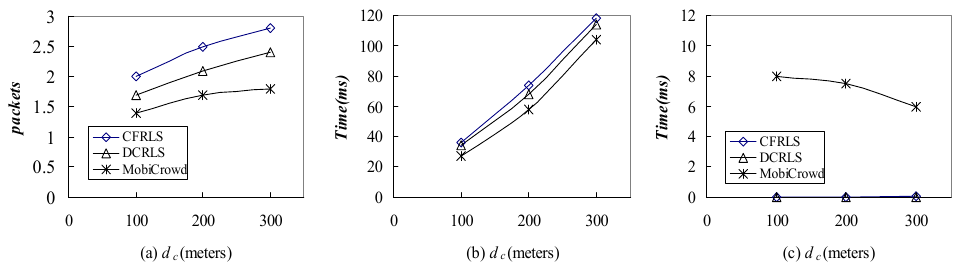
Figure 13. Comparison of ( a ) communication costs, ( b ) client costs, ( c ) server costs with different algorithms.